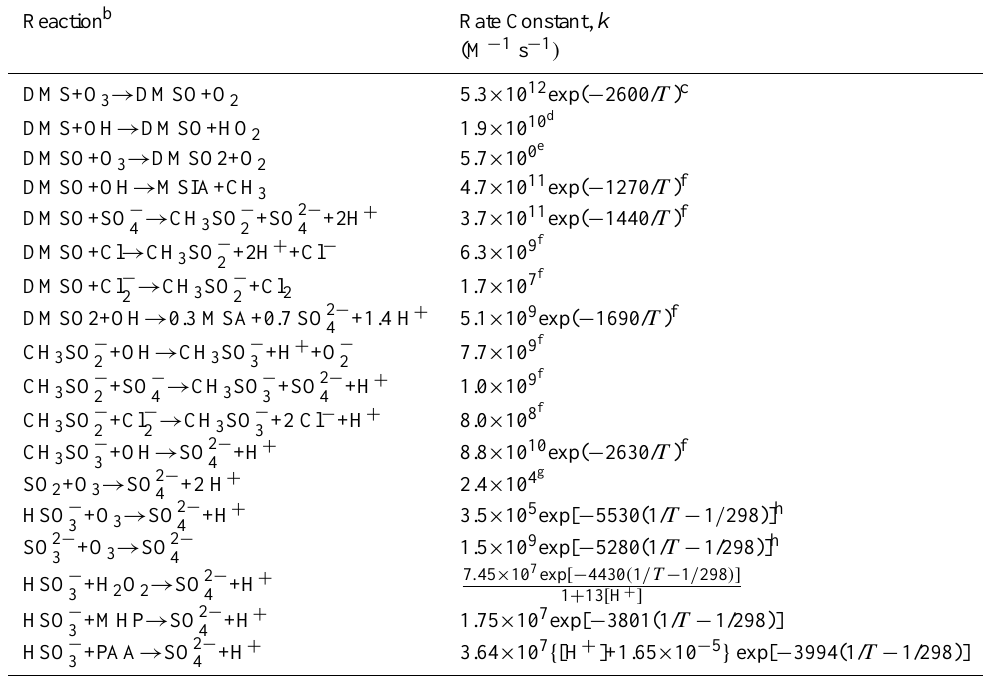
Table 4. Revised set of heterogeneous cloud reactions in CMAQ4.6. a . Reaction